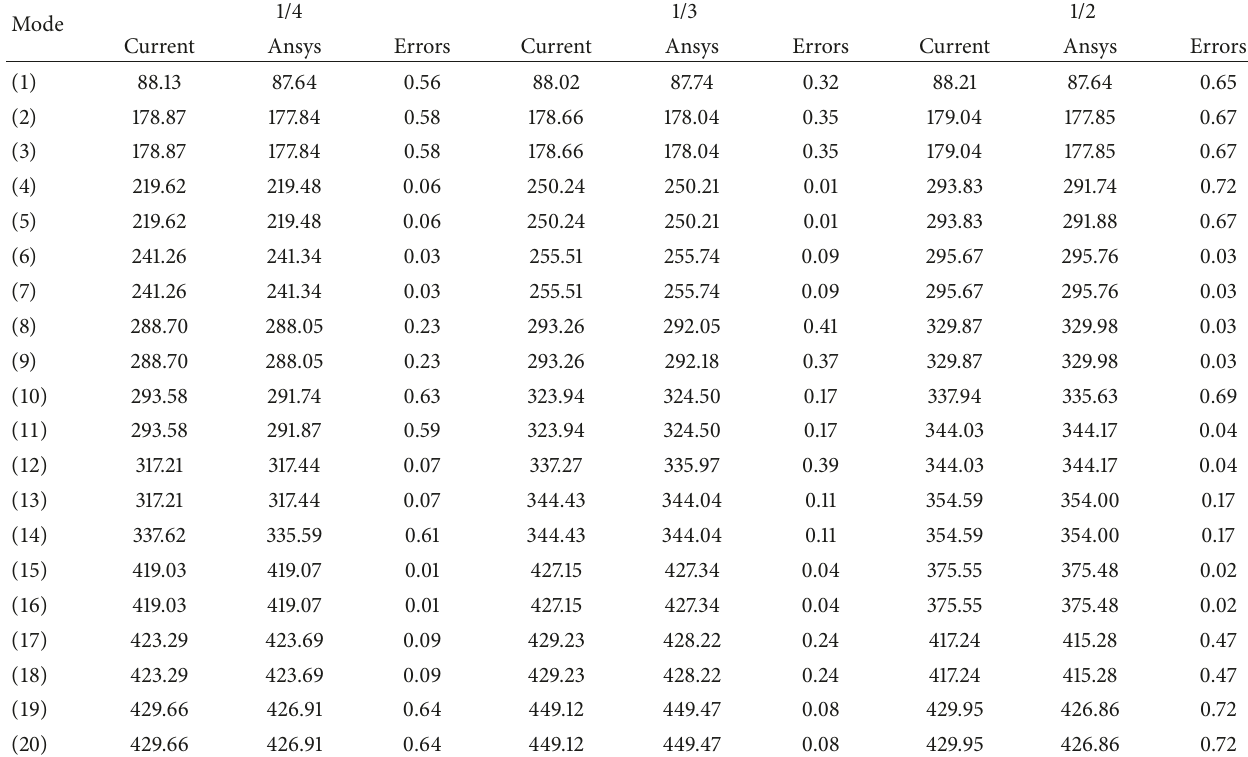
Table 3: The frequency of the coupled structures with different coupling-junction positions 𝑓